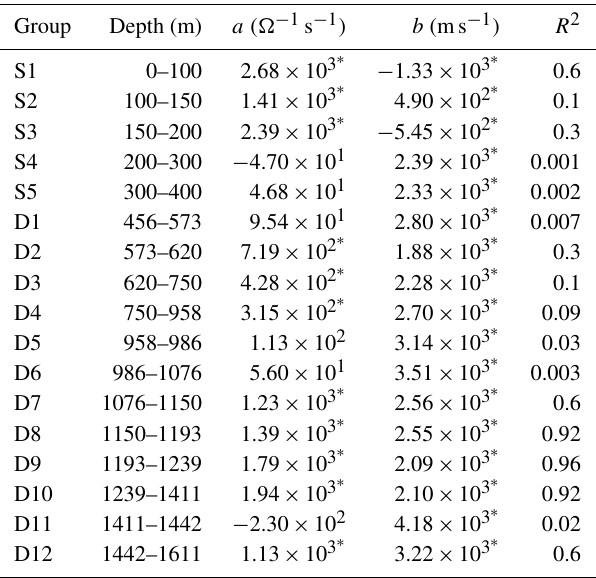
Table 1. Empirical relationship ER1: linear regression of V vs. log( R